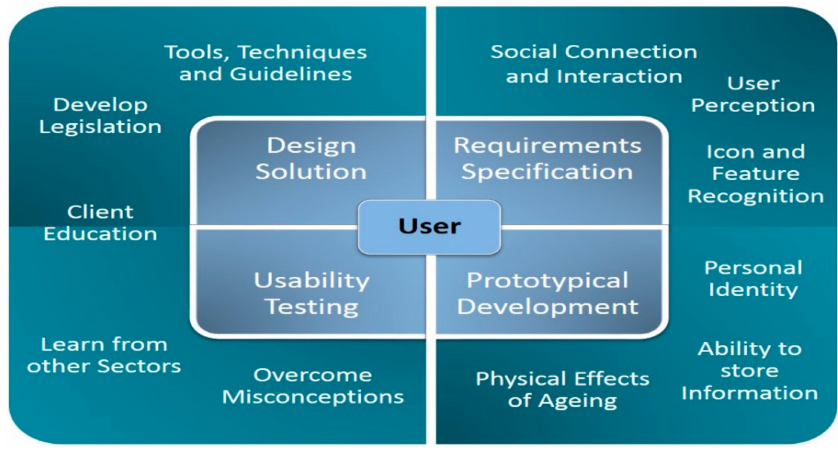
Figure 3. Consideration